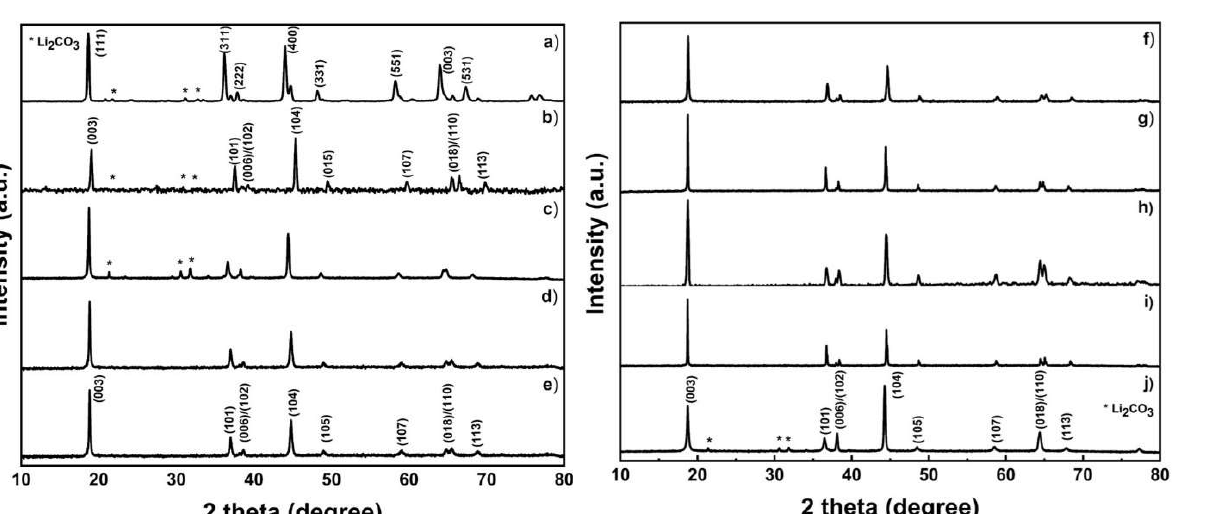
Table 4. The lattice parameter of LMO, LCO, LNO, and NMC at various compositions.